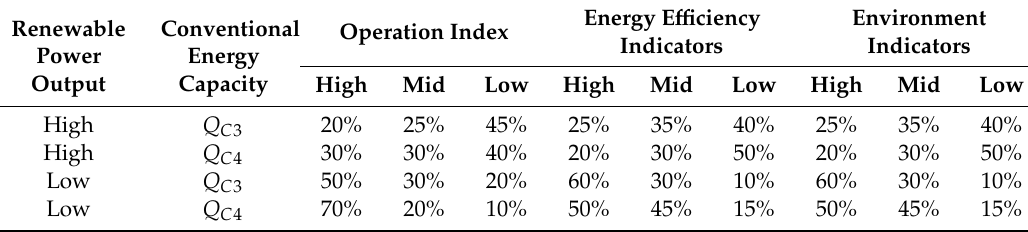
Table 7. The target probability distribution in the second stage of decision making under low load